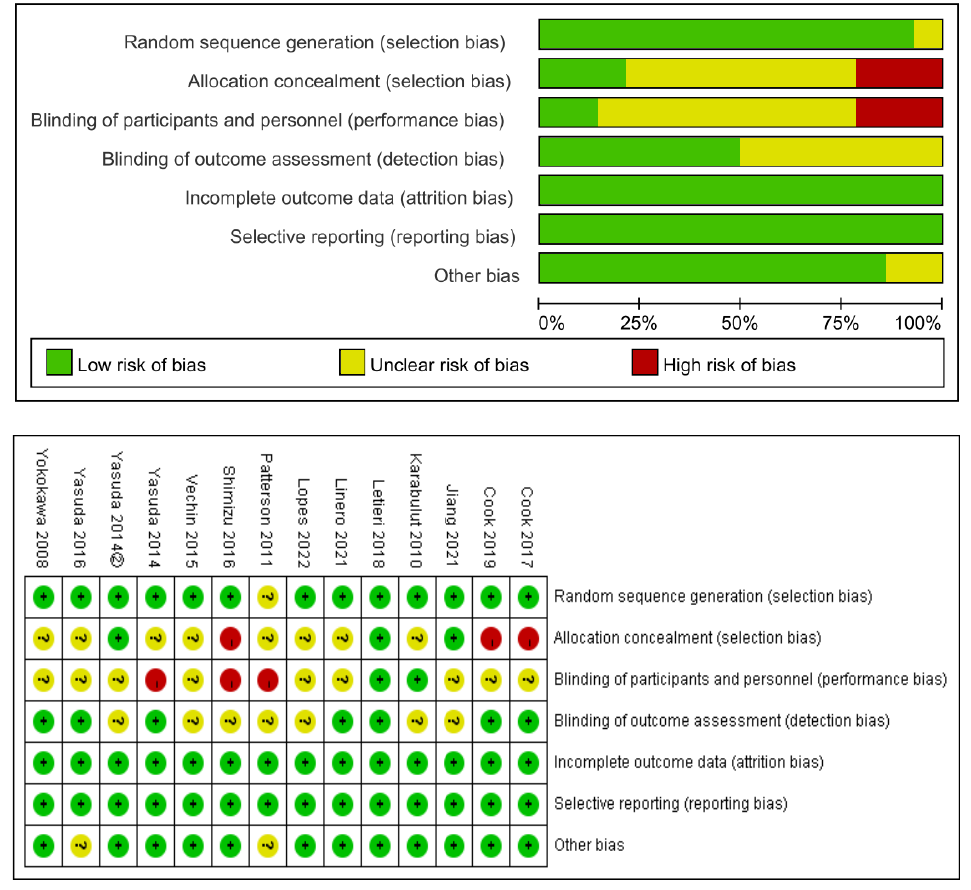
Figure 2. Risk of bias graph [9,17 –